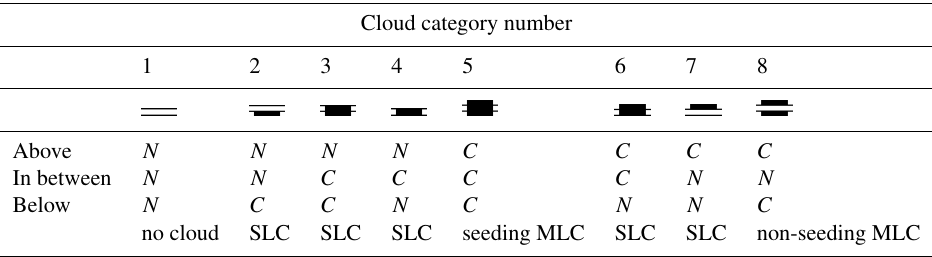
Table 1. Overview of the classification into eight different cloud categories. N means no cloud and C means cloud. SLC means single-layer cloud and MLC means multilayer